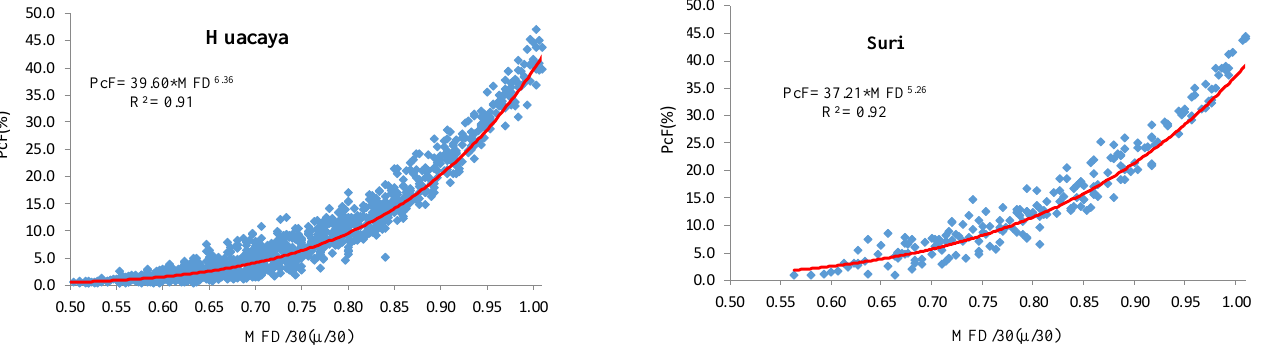
PcF= 39.60*MFD 6.36 R² = 0.91